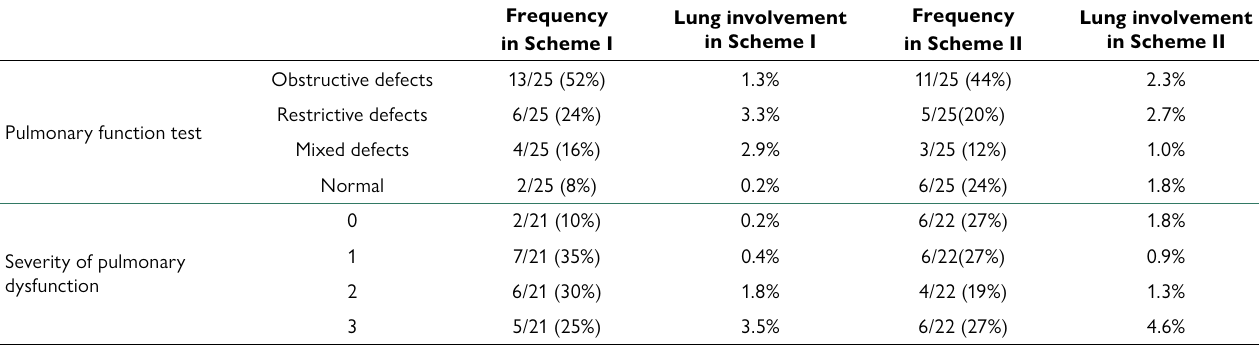
Table 2. Pulmonary function tests and severity of pulmonary dysfunction in patients who were treated with Schemes I and II. Lung damage is represented as a